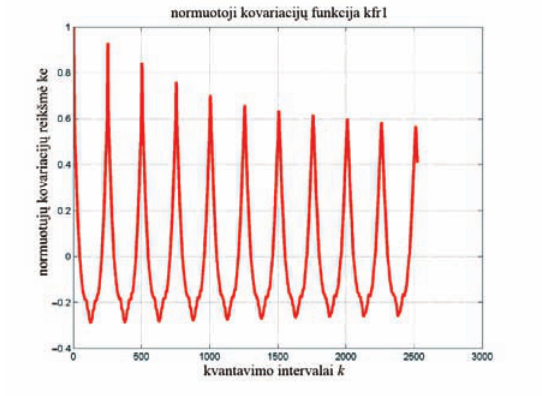
Fig. 7. The interrelation of normalized covariance function of digitals images for the lenses of the eye without contact lenses